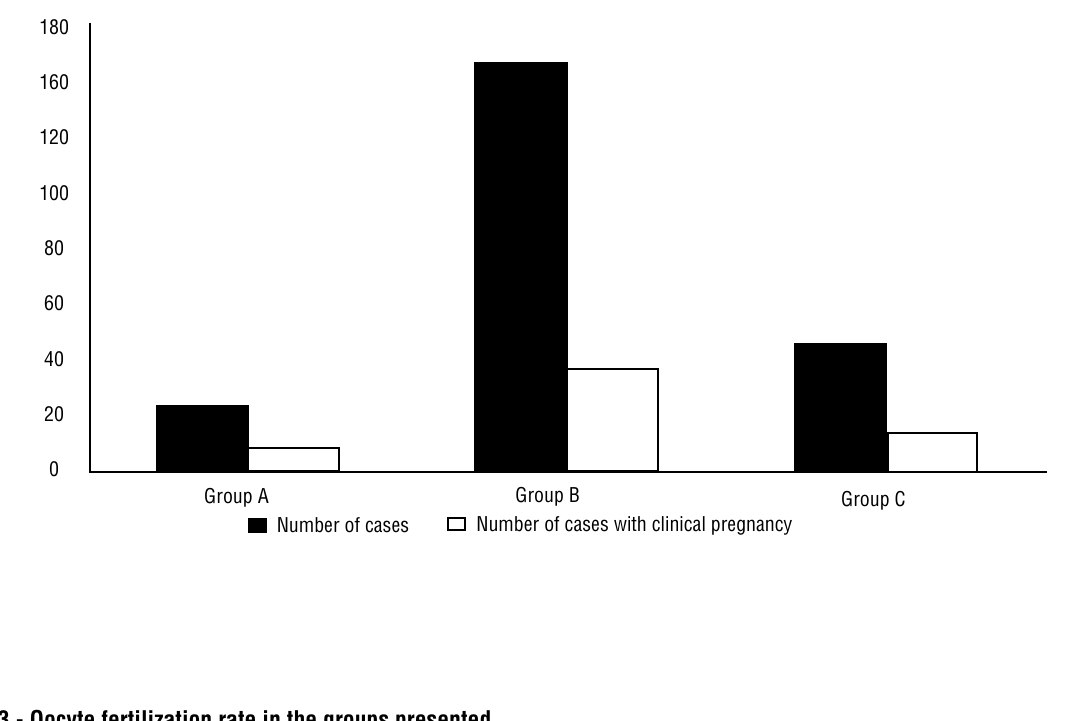
Figure 3 - Oocyte fertilization rate in the groups